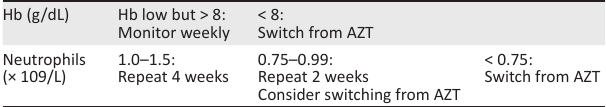
TABLE 13: Guidelines for managing haematological toxicity (mainly zidovudine- induced). Hb (g/dL) Hb low but > 8: Monitor